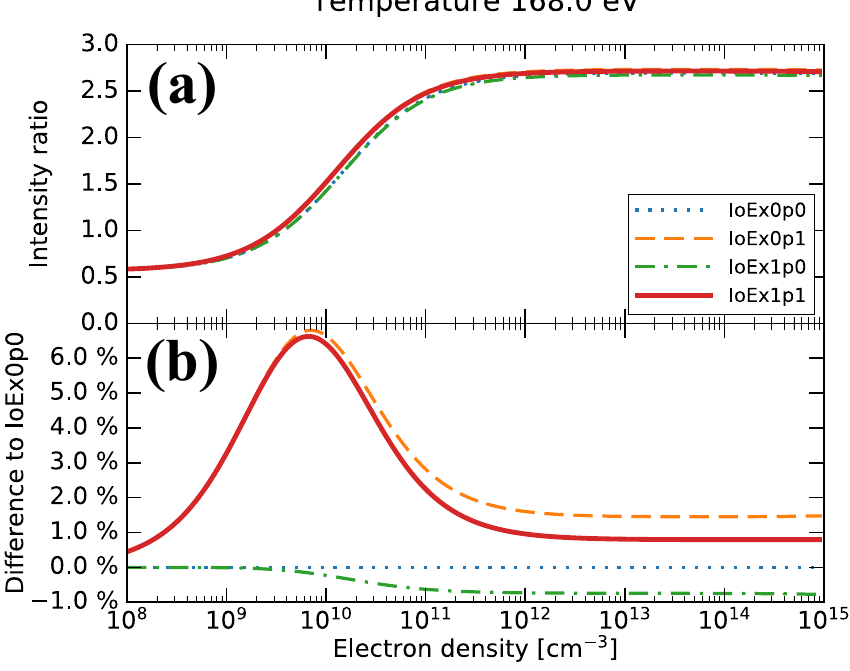
Figure 2. ( a ) Electron density dependence of Fe XIV 264.785 Å/274.203 Å intensity ratios for four models at electron temperature 168 eV. ( b ) Difference between models relative to IoEx0p0 model. Steel-blue dotted line: IoEx0p0 model without proton-impact excitation and ionization processes to excited states of Mg-like iron ion; dark-orange dashed line: IoEx0p1 model with ionization processes to excited states but without proton-impact excitation process; forest-green dash-dotted line: IoEx1p0 model with proton-impact excitation processes but without ionization processes to excited states; and red solid line: IoEx1p1 model with proton-impact excitation and ionization processes to excited